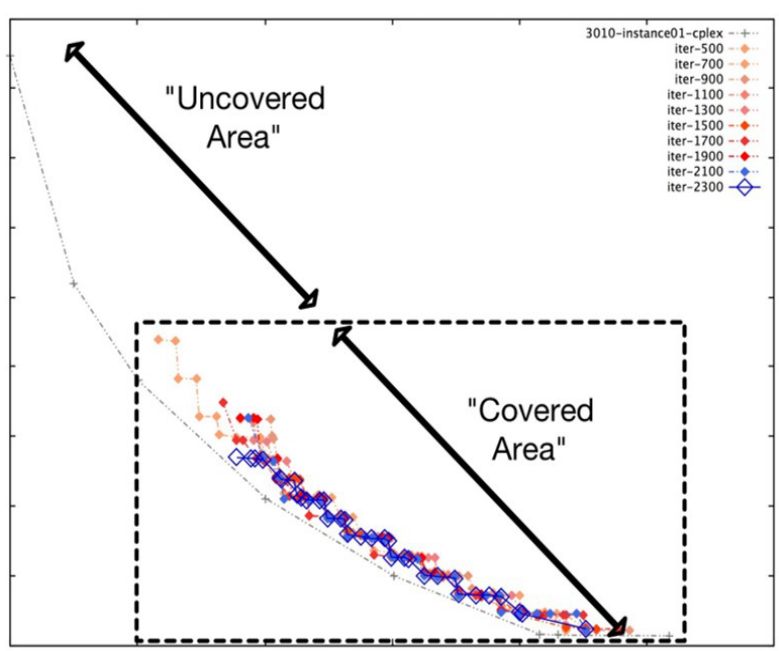
Figure 4. NSGA-II algorithm struggles to cover the whole Pareto